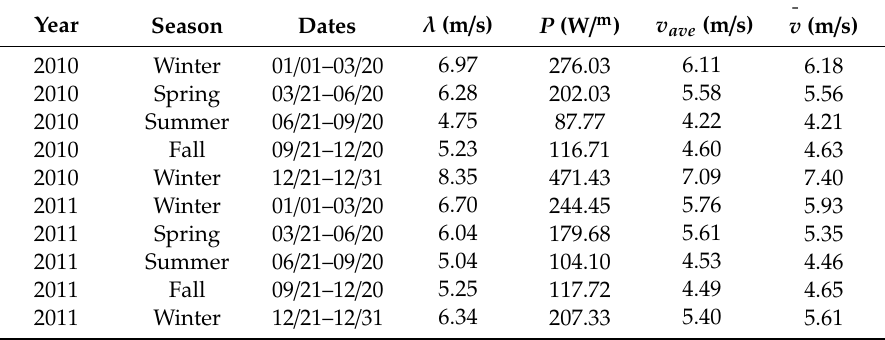
Table 3. Characteristics of the wind resource per season: scale parameter λ , average power P , average wind speed from data v ave and mean wind speed from Weibull distribution v .